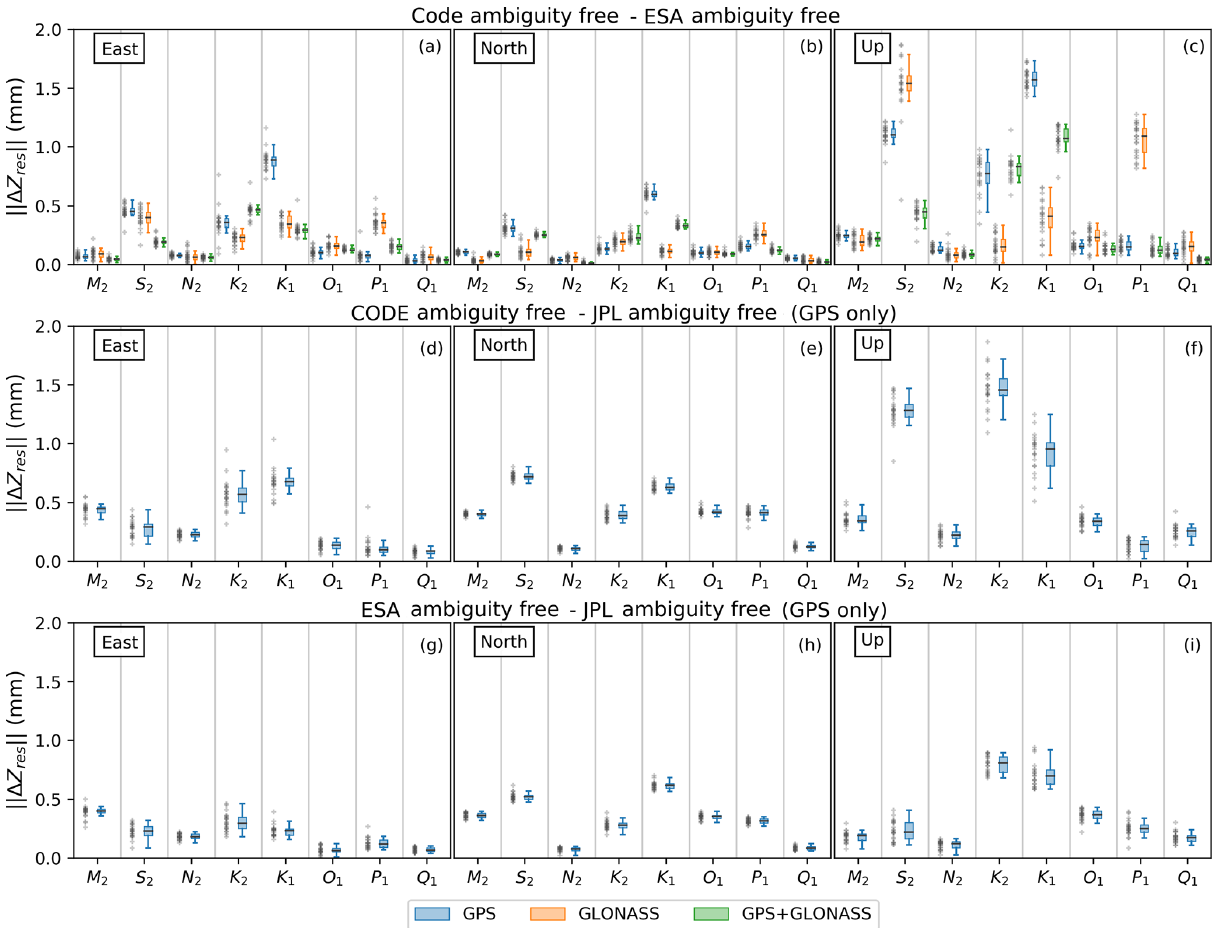
Figure 5. OTL vector differences between CODE, ESA and JPL solutions (ambiguity free). (a–c) GPS, GLONASS and combined GPS+GLONASS differences between CODE and ESA solutions; (d–f) GPS difference between CODE and JPL solutions (ambiguity free); (g–i) GPS difference between ESA and JPL solutions (ambiguity free). Note the vertical scale of 2mm. Grey crosses are as per Fig. 3.